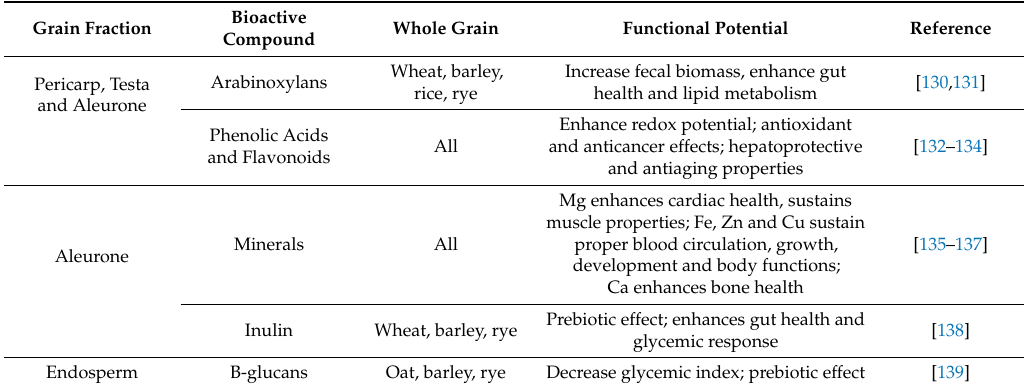
Table 8. Major functional food compounds in whole grains (adapted from Rawat et al. (2013) [48]). Bioactive Grain Fraction